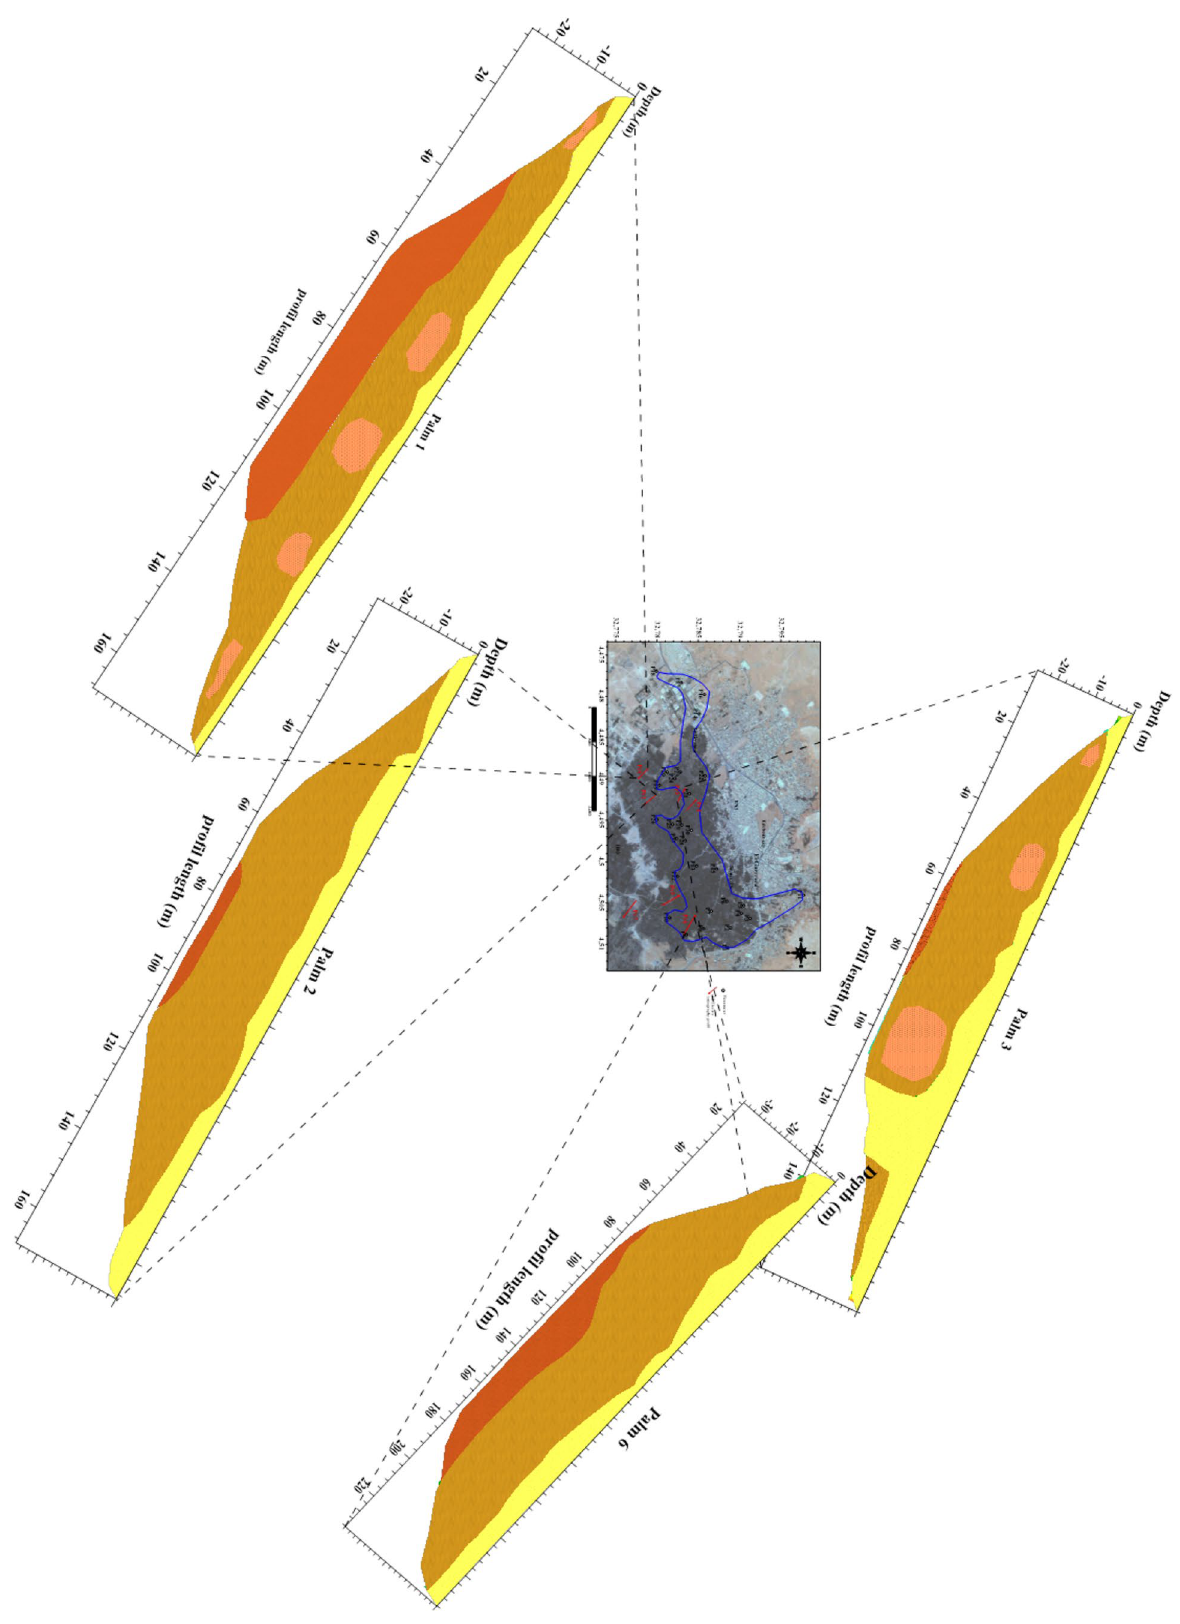
Fig. 8 Geologic model obtained from the interpretation of the 2D electric